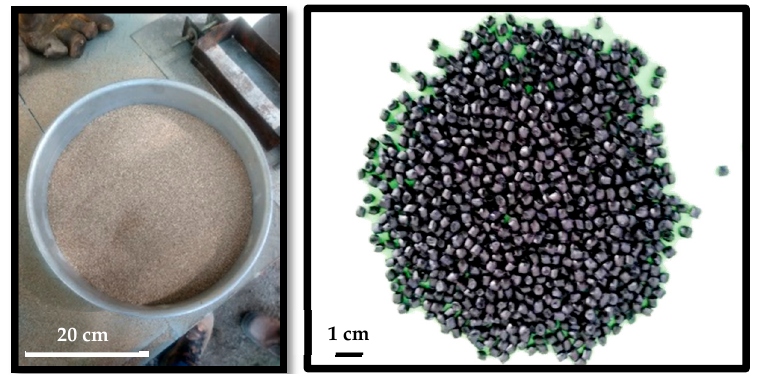
Figure 1. Sand and plastic pellets used in the manufacturing of plastic sand cobbles. Commercially available silica sand was used as an inert filler with a particle density of 2.65 g/cm 3 with 1.1% of fine aggregate and a sieve analysis (INV E 123-13) shows in Figure 2.